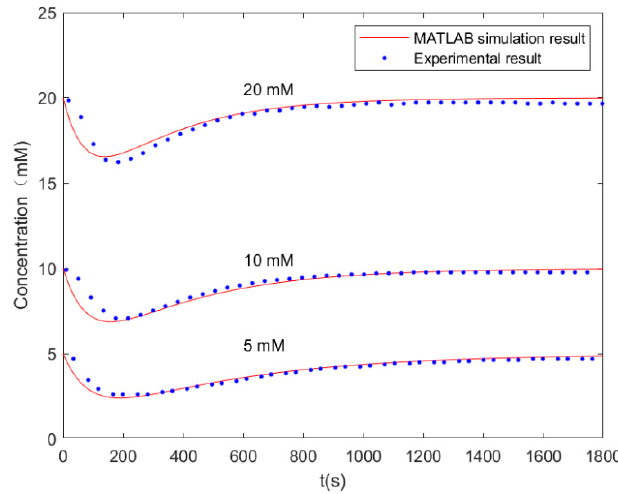
Figure 4. Comparison of MATLAB programming simulation results with experimental results.